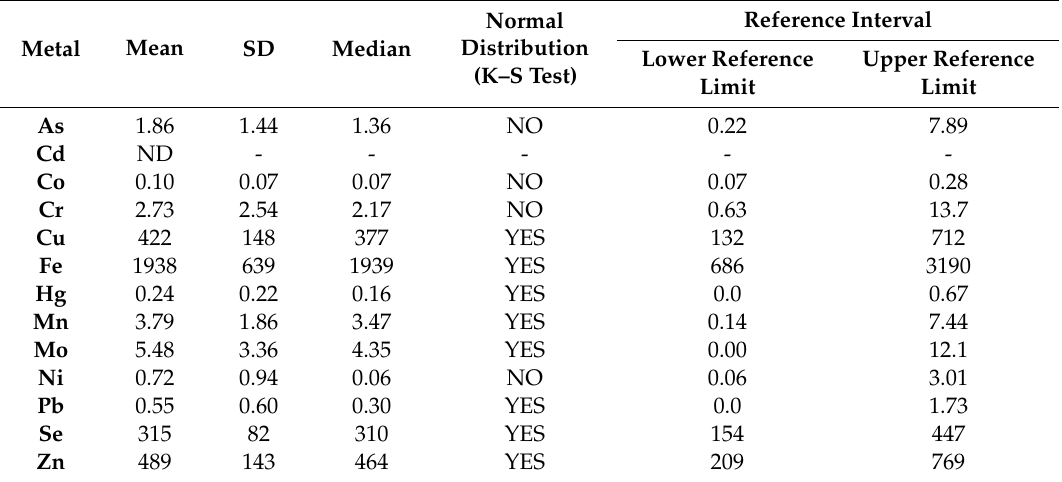
Table 2. Descriptive statistic for trace and toxic element concentrations in serum of the healthy / normal